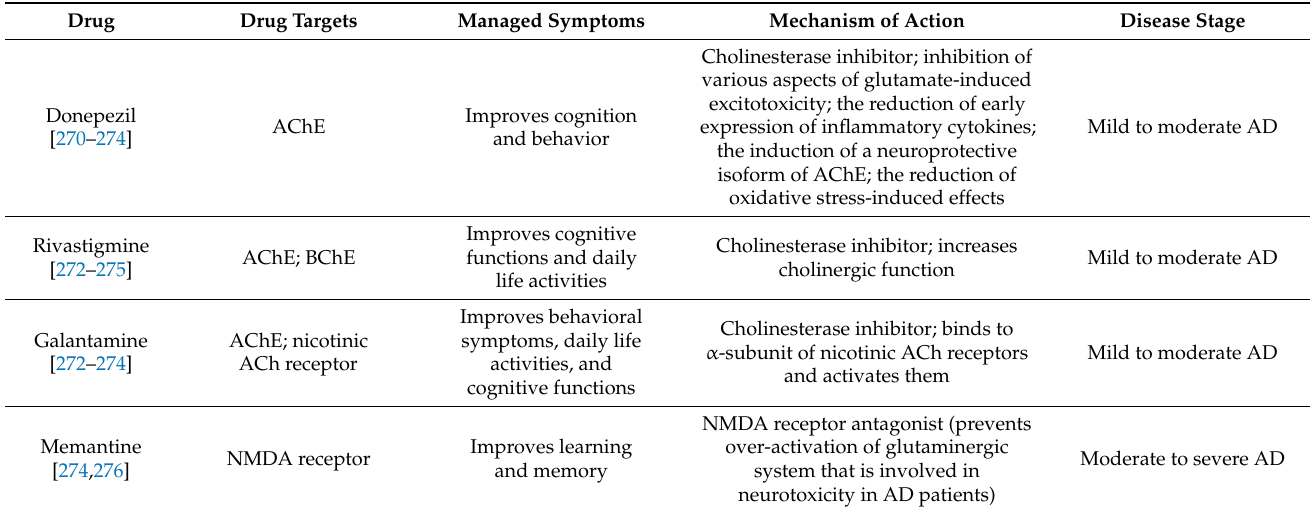
Table 3. Approved symptomatic pharmacological treatments for patients with